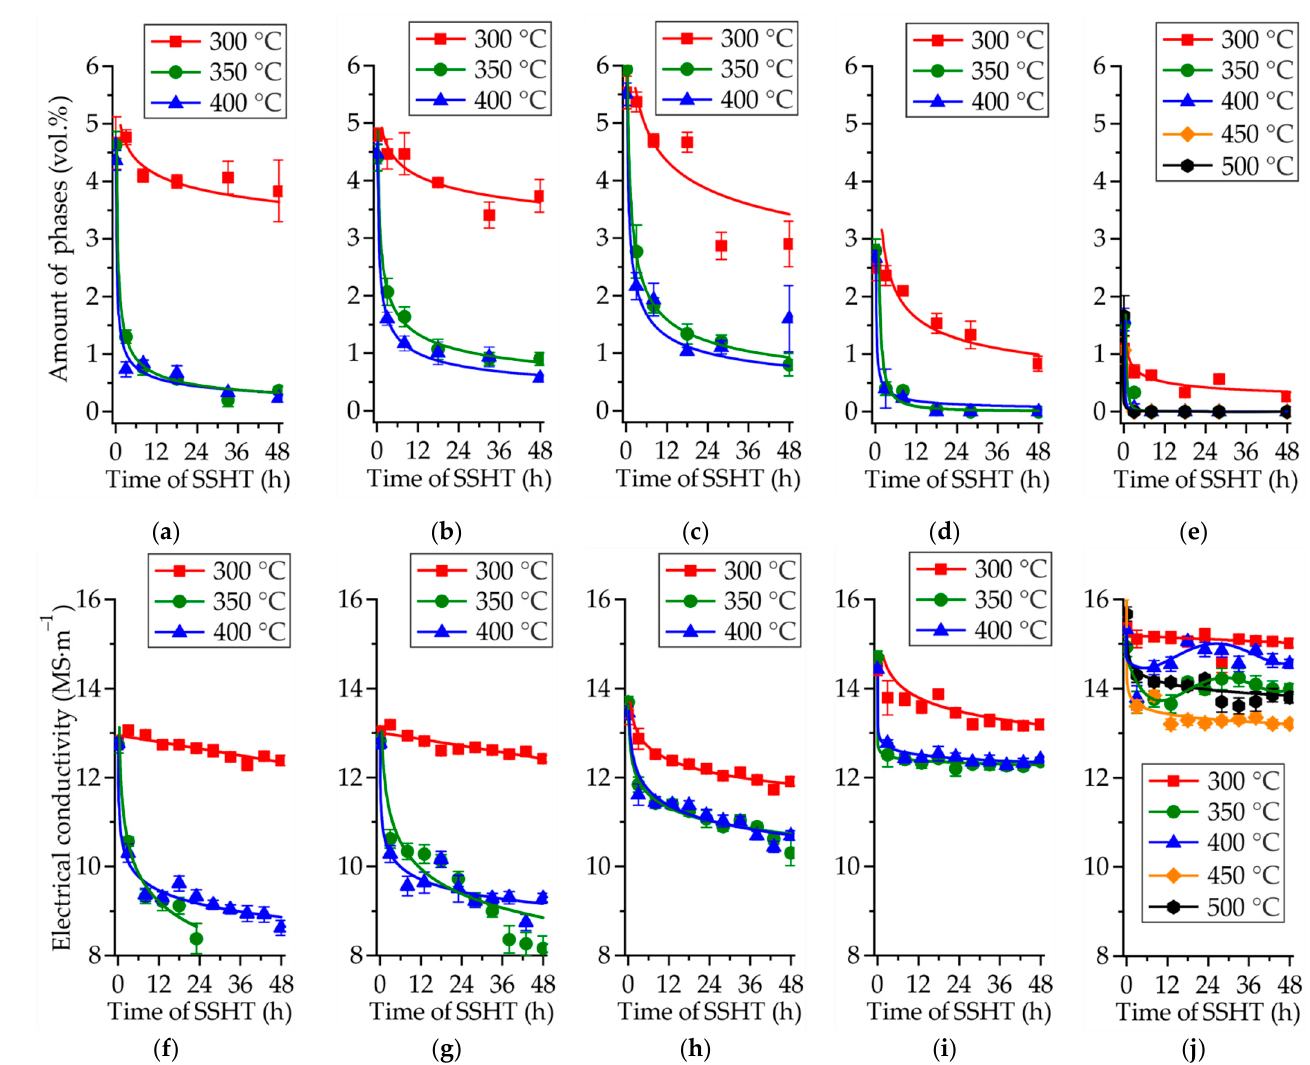
Figure 4. Amounts of intermetallic phases (Mg 7 Zn 3 , Mg 5 Ga 2 , and GaY) ( a – e ) and electrical conductivity ( f – j ) of the Mg–Zn–Ga alloys: ( a , f ) MgZn4Ga4, ( b , g ) MgZn4Ga4Y0.5, ( c , h ) MgZn6.5Ga2, ( d , i ) MgZn4Ga2, and ( e , j ) MgZn2Ga2, during SSHT at different temperatures.